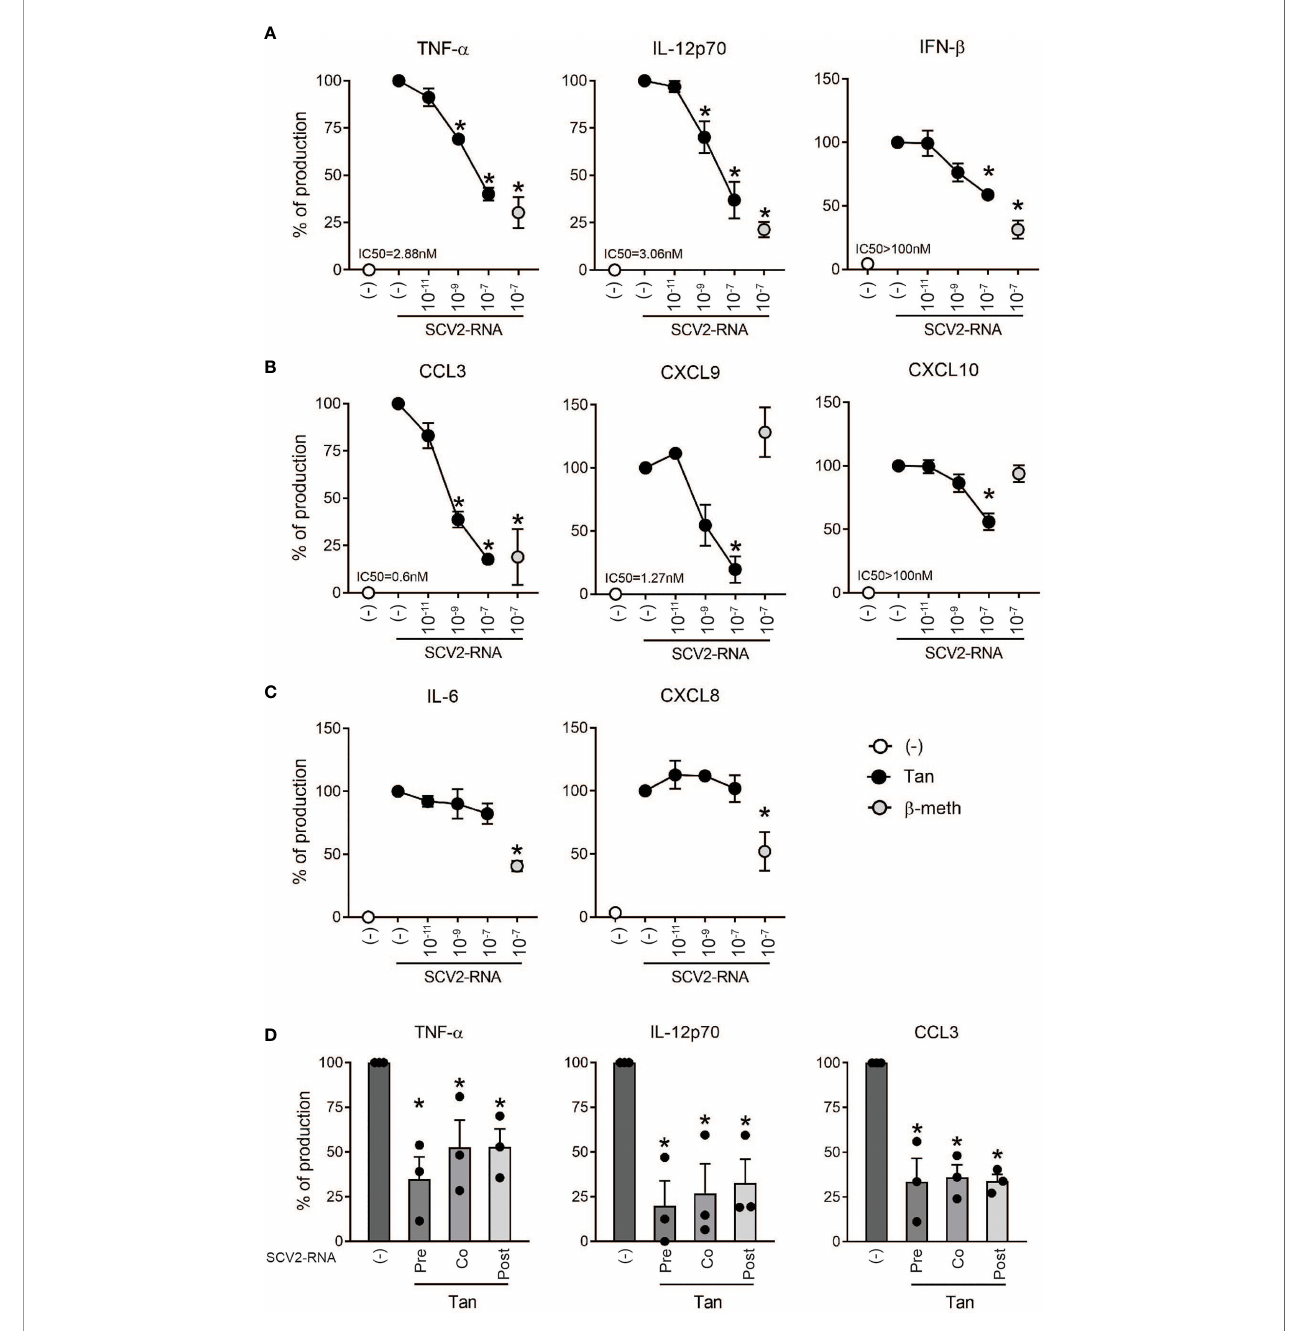
FIGURE 1 | Effect of Tanimilast on cytokine and chemokine secretion by moDCs challenged with SCV2-RNA. (A – C) moDCs (2x10 6 /ml) were pre-treated or not (-) with the indicated doses of Tanimilast (Tan) or b -methasone ( b -meth) for 1 hour and then stimulated with SCV2-RNA (5 m g/ml) for 24 hours. (D) Tanimilast (Tan) was added 1 hour before (Pre), together (Co) and 1 hour after (Post) the stimulation with SCV2-RNA. Cytokine (A, C, D) and chemokine (B, C, D) production was evaluated by ELISA in cell-free supernatants. Cytokine/chemokine expression was normalized to SCV2-RNA condition (represented as 100%) to control donor- dependent variation. Absolute levels of SCV2-RNA induced cytokines (ng/ml) were: TNF- a =154.79 ± 26.37; IL-6 = 131.66 ± 16.8; IL-12 = 62.53 ± 21.5; IFN- b =0.38 ± 0.2; CCL3 = 42.21 ± 9.79; CXCL9 = 76.1 ± 22.7; CXCL10 = 33 ± 5.8 and CXCL8 = 94.1 ± 10.6. Data are expressed as mean ± SEM (n=3); *P< 0.05 versus SCV2-RNA by one-way ANOVA with Dunnett ’ s post-hoc test. IC50 was calculated by GraphPad Prism nonlin fi t log(inhibitor) vs.